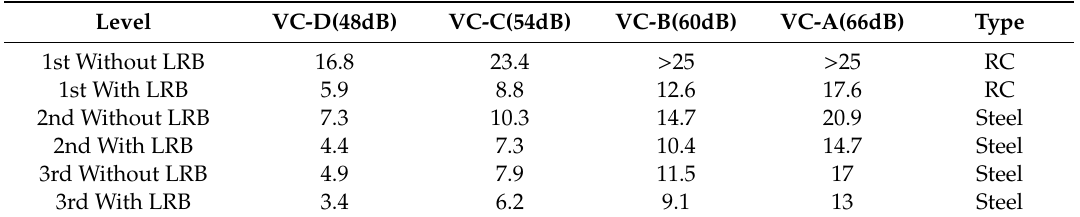
Figure 11. Turbulent wind velocity at the height of 30 m on the building center. Table 3. The minimax average wind speed (m / s) during 10 min for the criteria of the micro-vibration for the studied high-tech factory.